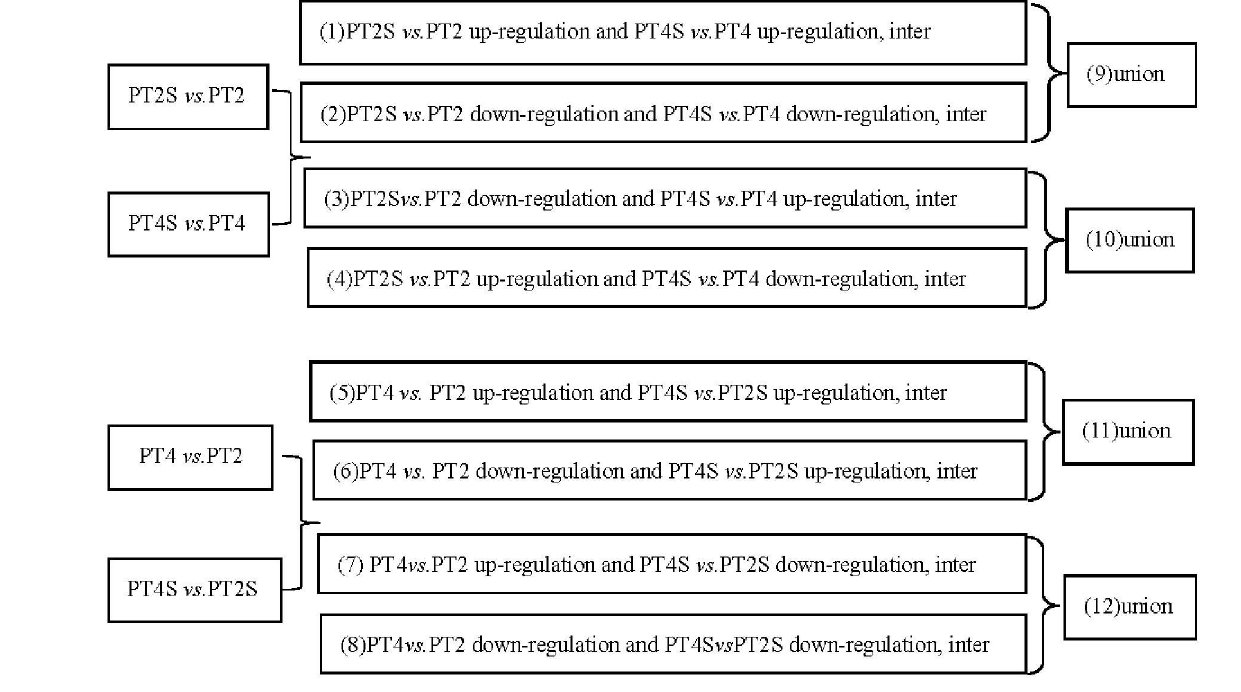
regulation in the PT4 vs . PT2 comparison but up-regulation in the PT4S vs . PT2S comparison. (7) DEGs up-regulation in the PT4 vs . PT2 comparison but down-regulation in the PT4S vs . PT2S comparison. (8)DEGs co-down-regulation in the PT4 vs . PT2 and PT4S vs. PT2S com- parison. Comparison A: (1) and (2). Comparison B: (3) and (4). Comparison C: (5) and (6). Comparison: from (7) and (8).